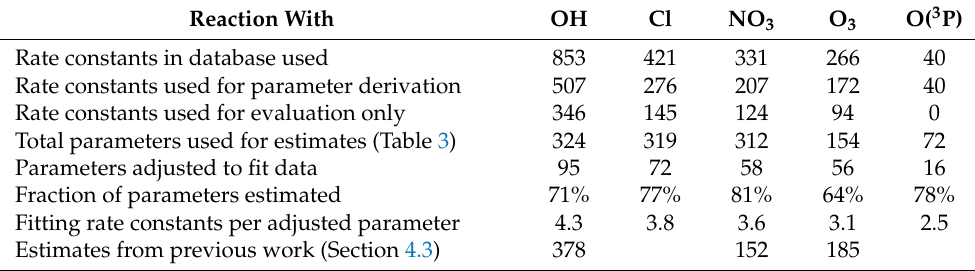
Table 2. Summary of numbers of rate constants and estimation parameters used in this work. Reaction With OH Cl NO 3 O 3 O( 3 P) Rate constants in database used 853 421 331 266 40 Rate constants used for parameter derivation 507 276 207 172 40 Rate constants used for evaluation only 346 Total parameters used for estimates (Table 3) 324 Parameters adjusted to fit data 95 72 58 16 Fraction of parameters estimated 71% 77% 81% 78% Fitting rate constants per adjusted